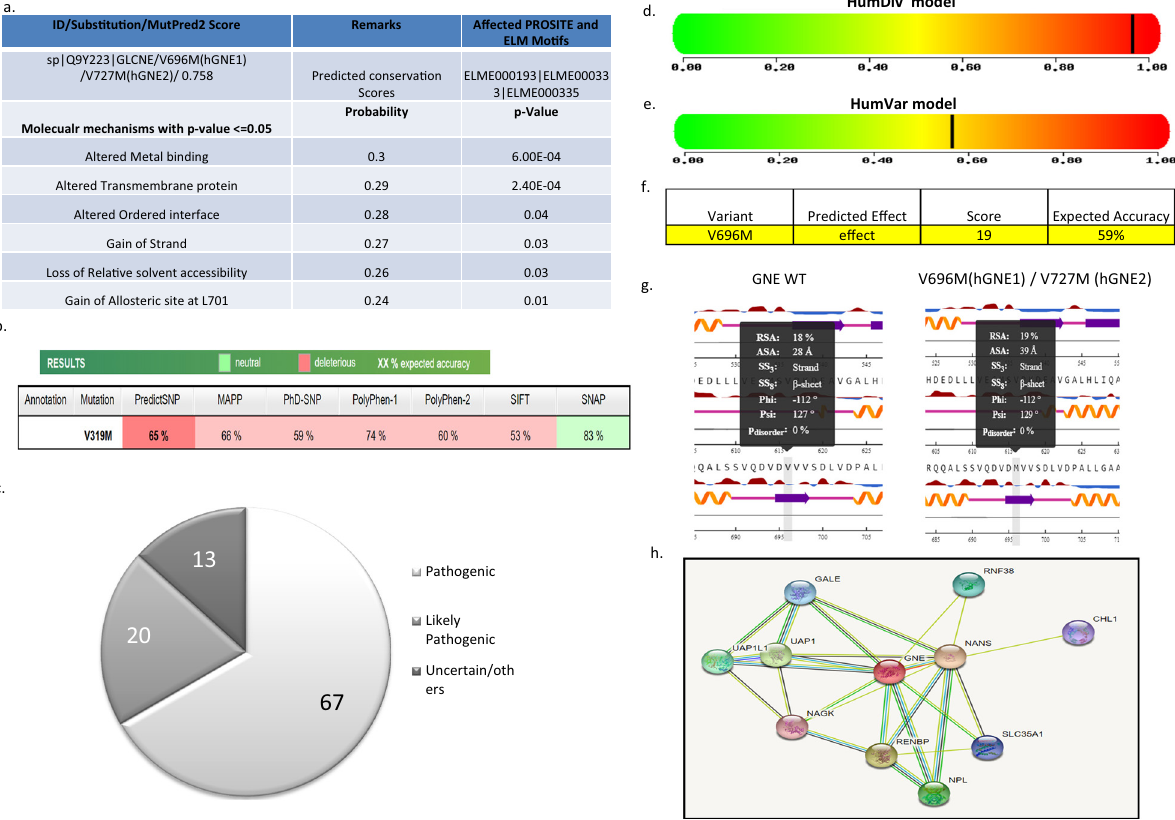
Figure 1: GNE V727M mutation e ff ect prediction on function and phenotype - associated properties using ( a ) MutPred; ( b ) PredictSNP; ( c ) ClinVar - based study; ( d ) HumDivmodel; ( e ) HumVar model; ( f ) SNAP2 analysis; ( g ) NetSurfP analysis; and ( h ) susceptible interacting partners ( as per STRING analysis )